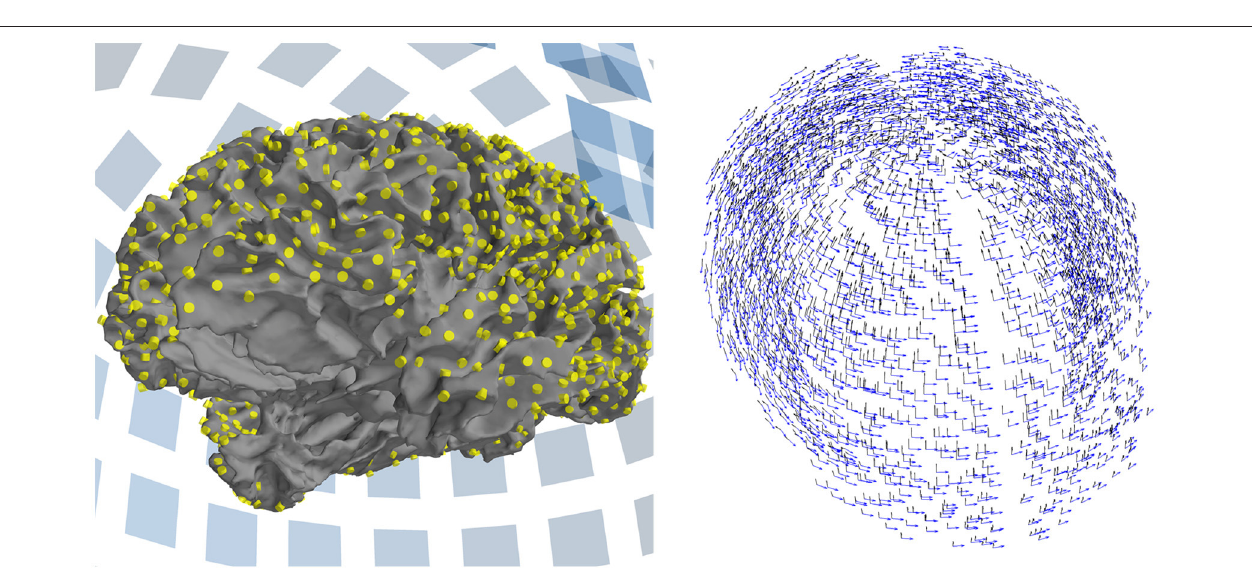
implementation can be found in the script